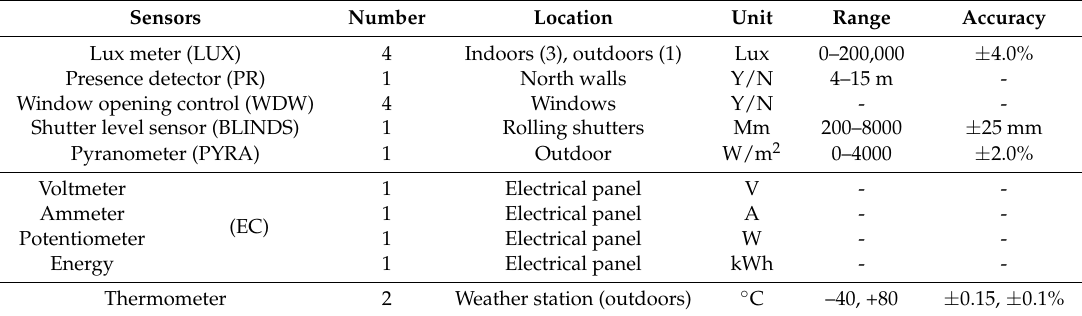
Table 1. Sensors in the monitored room and weather station. Source: Data sheets from manufacturer.